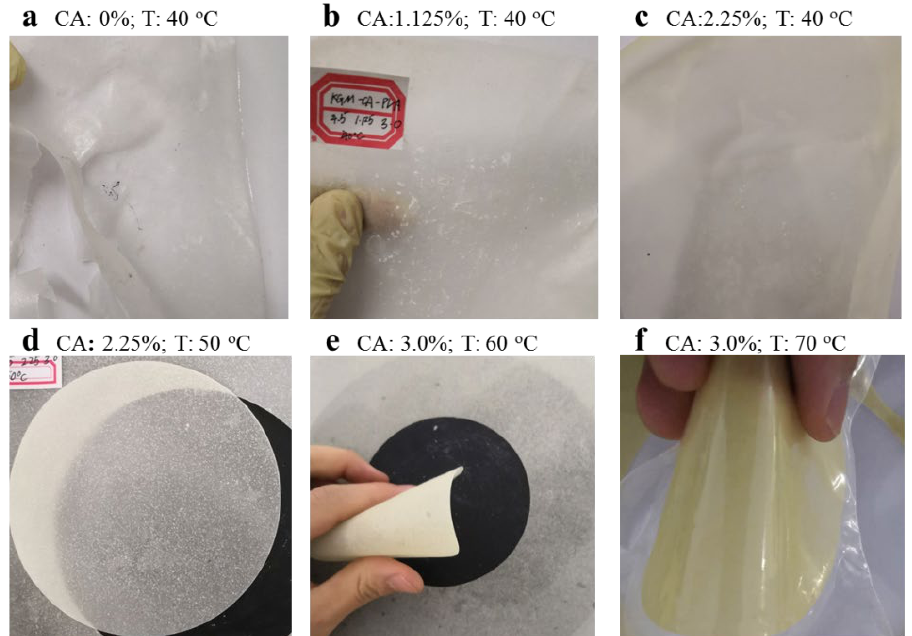
Figure 2. Film-forming properties of different KGM/CA/PVA ternary blend adhesive. Preparation conditions of KGM/CA/PVA ternary blend adhesive: the content of KGM and PVA were 4.5% and 3.0% respectively, the pH value is 5.0.